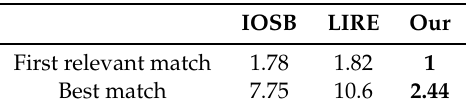
Table 8. Average rank of the first relevant match measured on TestSet50. The metric is interpreted as the lower the better with lower bound